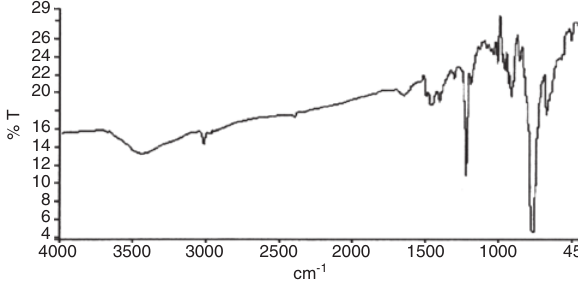
Figure 3: IR Spectrum of MoO